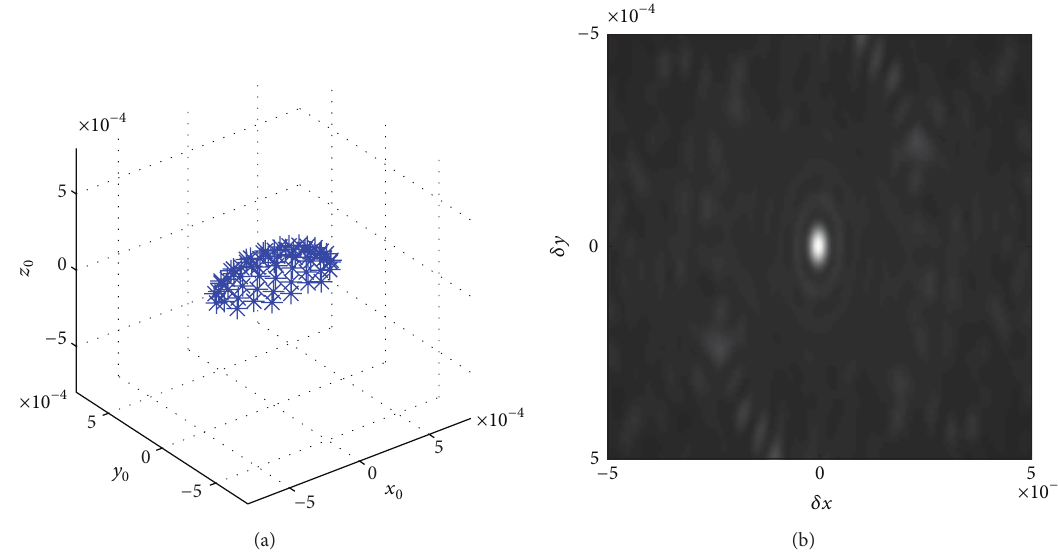
Figure 10: Half ellipsoid composed of 60 Dirac emitters uniformly located (a) and zoom of the central peak of the 2D-autocorrelation of the interferometric out-of-focus image created by this object (b). All axes are in